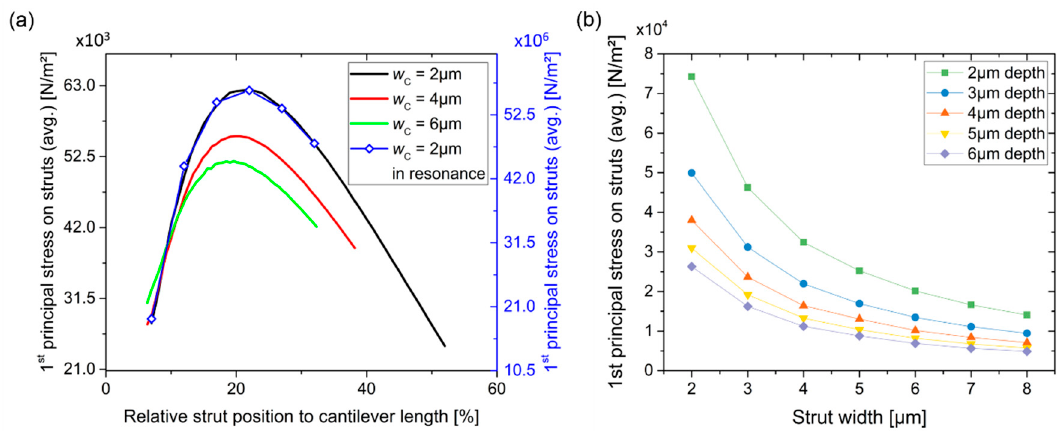
Figure 5. First principle stress on average over a piezo-resistive strut ( a ) vs. strut position along the cantilever length and ( b ) vs. strut width with strut/cantilever thickness as the parameter to the curves.